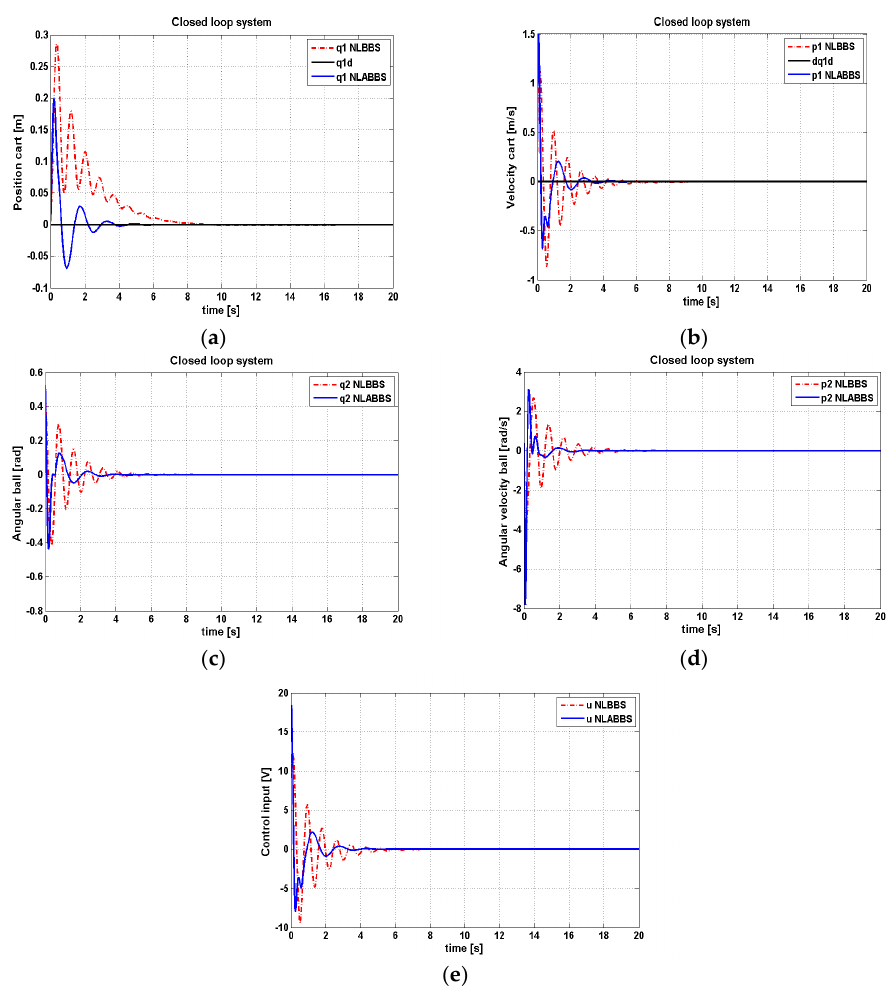
Figure 5. Evolution of the optimized parameters versus iterations: ( a ) conventional block-backstepping controller; ( b ) adaptive block-backstepping controller.